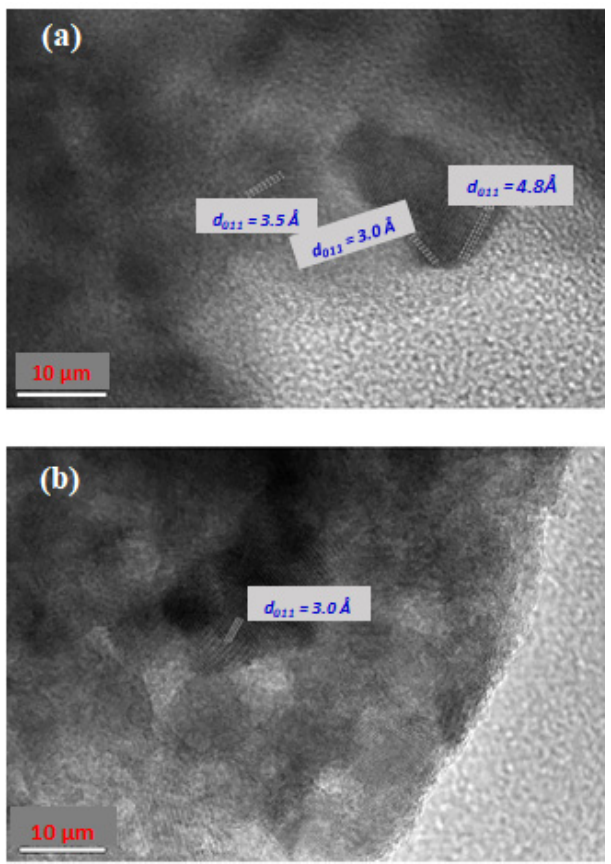
Figure 13. TEM images of the magnetic nanocomposites: ( a ) Co 0.5 Zn 0.25 Ni 0.25 Fe 2 O 4 /TiO 2 and ( b ) Co 0.5 Zn 0.25 Cu 0.25 Fe 2 O 4 /TiO 2 [117]. d 011 demonstrates the different of diameter of particles. Catalysts 2021 , 11 , 1543 17 of 33 Republished with permission from Elsevier.